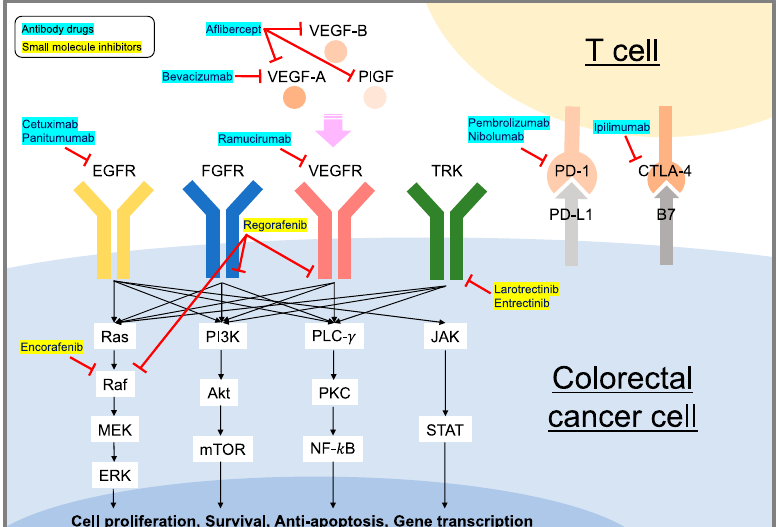
Figure 1. Comprehensive overview of FDA-approved targeted drugs for mCRC. Abbreviations: EGFR: epidermal growth factor receptor; FGFR: fibroblast growth factor receptor; VEGFR: vascular endothelia growth factor receptor; TRK: tropomyosin receptor kinase; VEGF: vascular endothelial growth factor; PlGF: placenta growth factor; PD-1: programmed cell death 1; PD-L1: programmed cell death ligand 1; CTLA-4: cytotoxic T-lymphocyte-associated protein-4; B7: CD80/CD86; MEK: mitogen-activated protein kinase; ERK: extracellular signal-regulated kinase; PI3K: phosphoinositide 3-kinase; mTOR: mechanistic target of rapamycin; PLC- γ : phospholipase C- γ ; PKC: protein kinase C; NF- k B: nuclear factor-kappa B; JAK: Janus kinase; STAT: transducer and activator of